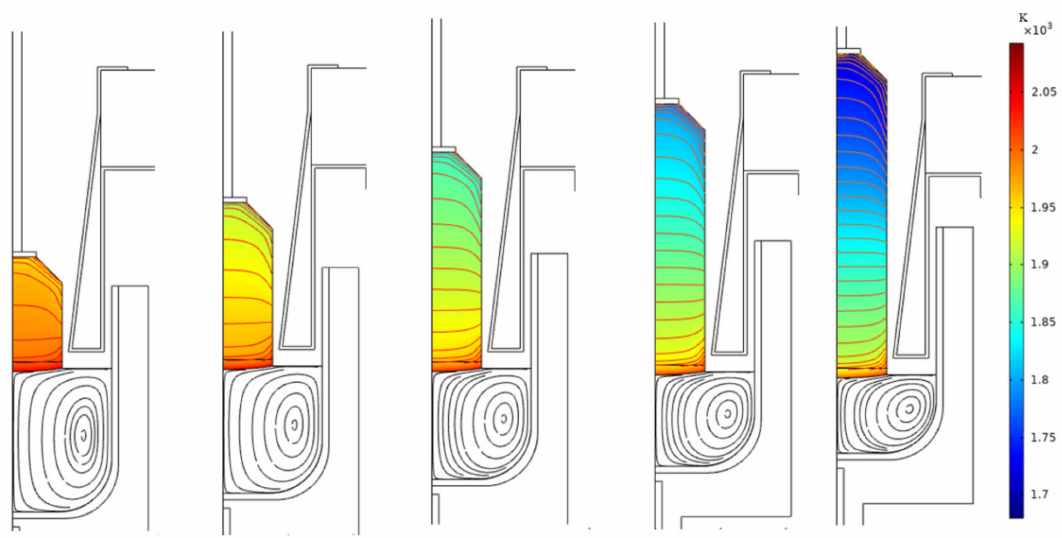
Figure 4. Temperature field of the crystal during the dynamic growth process.